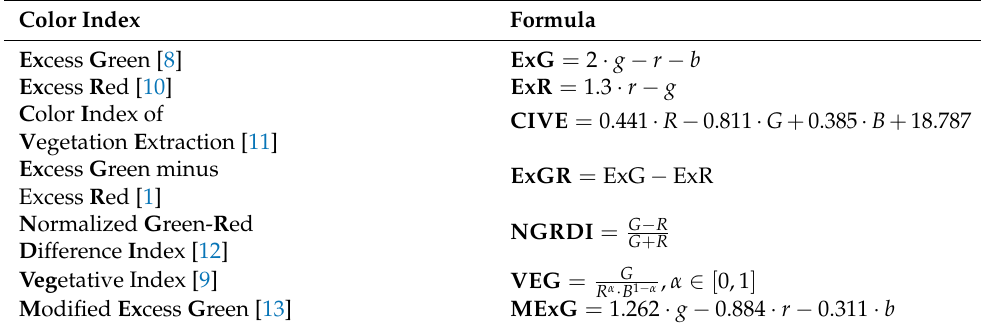
Table 1. Definition of color indices and first appearance. R , G , B ∈ [ 0,255 ] refer to 8-bit intensity values for each color channel, r , g , b ∈ [ 0,1 ] refer to the normalized chromatic coordinates, α ∈ [ 0,1 ] is a tuning parameter for the Vegetative Index and was set to α = 0.667 like in